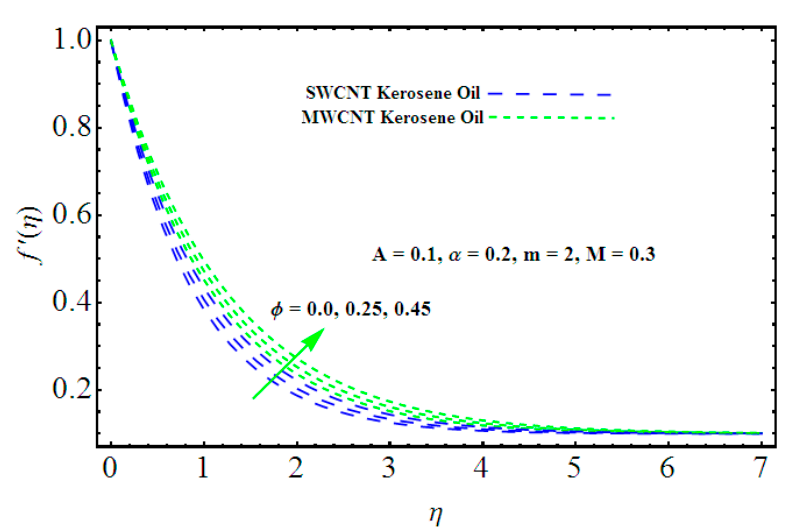
Figure 5. Impact of 𝜙 on velocity 𝑓 (cid:4593) (𝜂) .